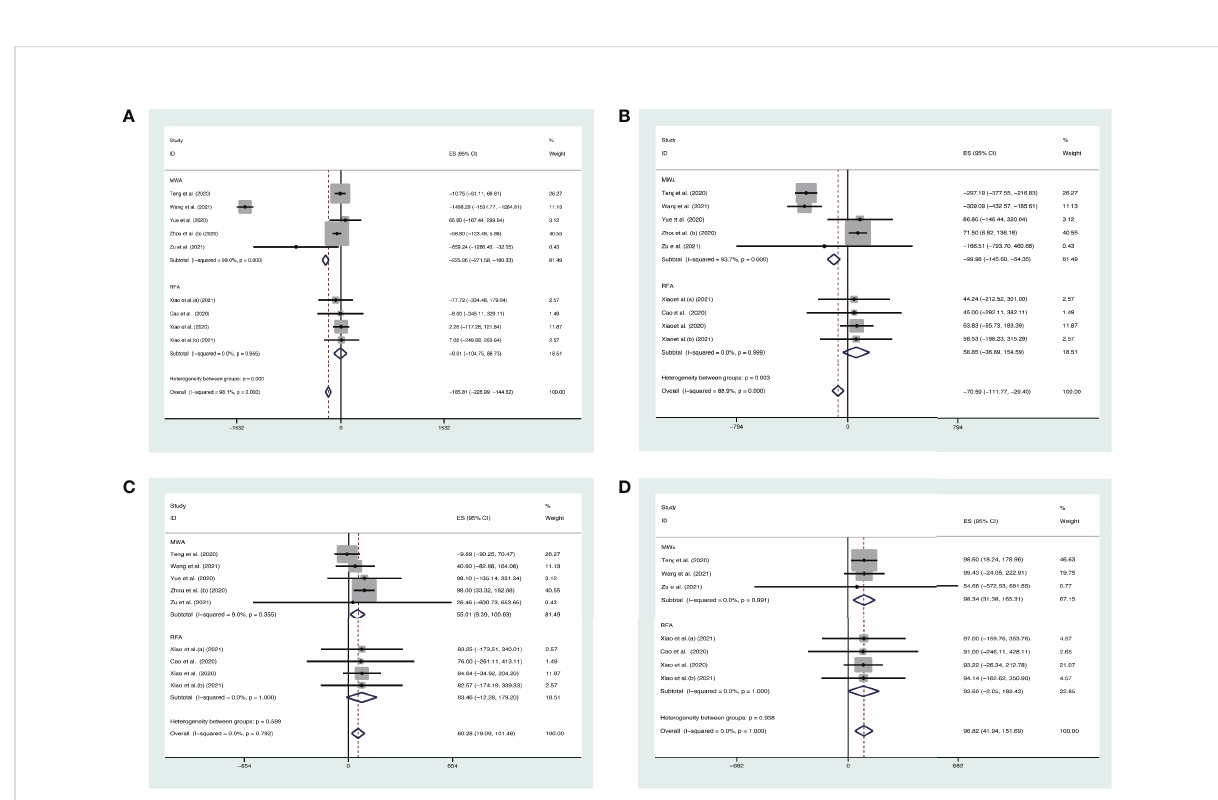
FIGURE 3 Forest plot of the effect of thermal ablations subgrouped by MWA and RFA on VAA (A) 3 months, (B) 6 months, (C) 12 months, and (D) 24 months after intervention.